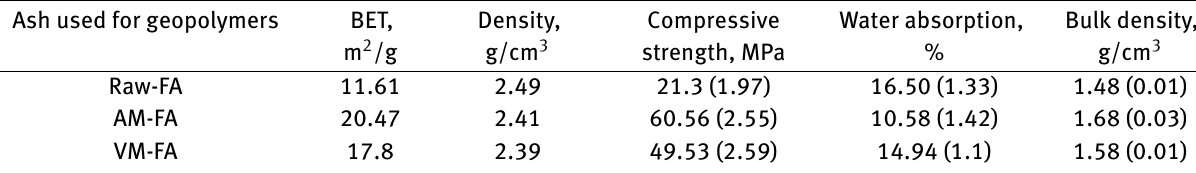
(Values in brackets indicate the standard deviation of repeated measurements.)